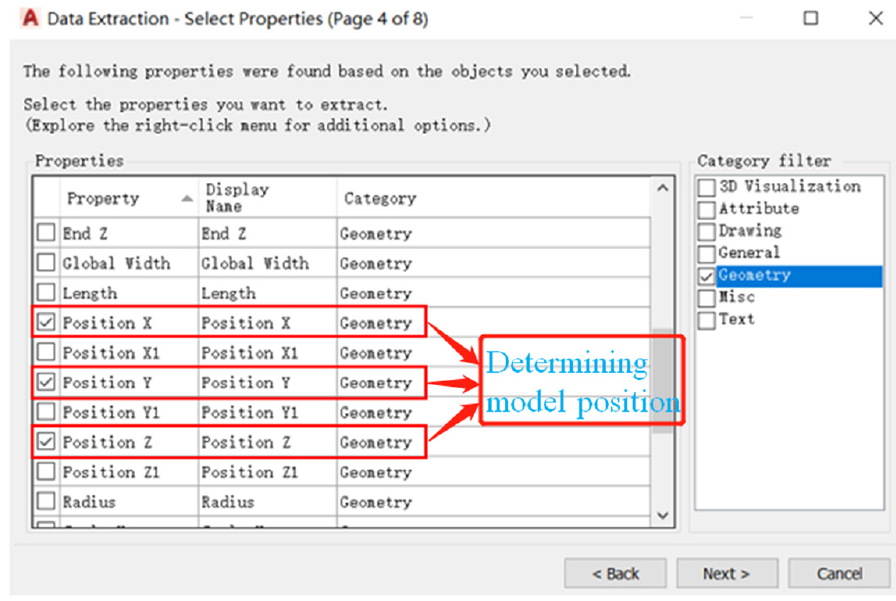
6 of 16 Figure 3. Representations of plants within four seasons: ( a ) spring; ( b ) summer; ( c ) fall; ( d ) winter. 3.1.2. Parameterized Planting Plant types in a landscape are usually diverse and large in number. A huge number of plants usually occupy a large area, which makes it difficult to determine the specific location of the model. In the virtual planting process, CAD, Excel, Revit, Dynamo, and other tools are used on the basis of a combination of parameterization to achieve precise positioning, batch creation, and corresponding coding information of the required plant models. Designers could use the program developed based on CAD, Excel, and Dynamo tools for modeling various plants in Revit much more efficiently. Such efforts could not only greatly improve the modeling efficiency but also make the model location more ac- curate and specific. Hence, precise planting of plant models based on parameterization